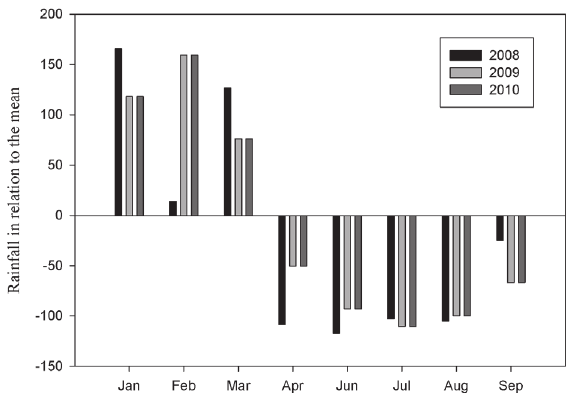
Figure 3 - Representation of the surplus/deficit of monthly rainfall in relation to the annual mean rainfall for the years 2008 to 2010.